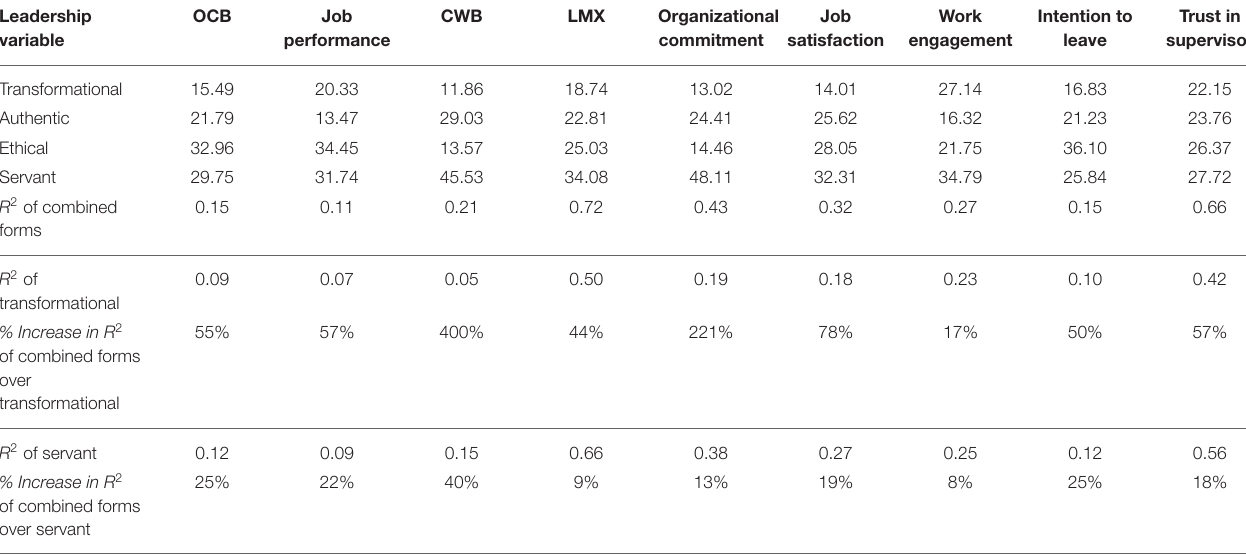
TABLE 6 | Relative weight analysis for transformational, authentic, ethical, and servant leadership. Leadership